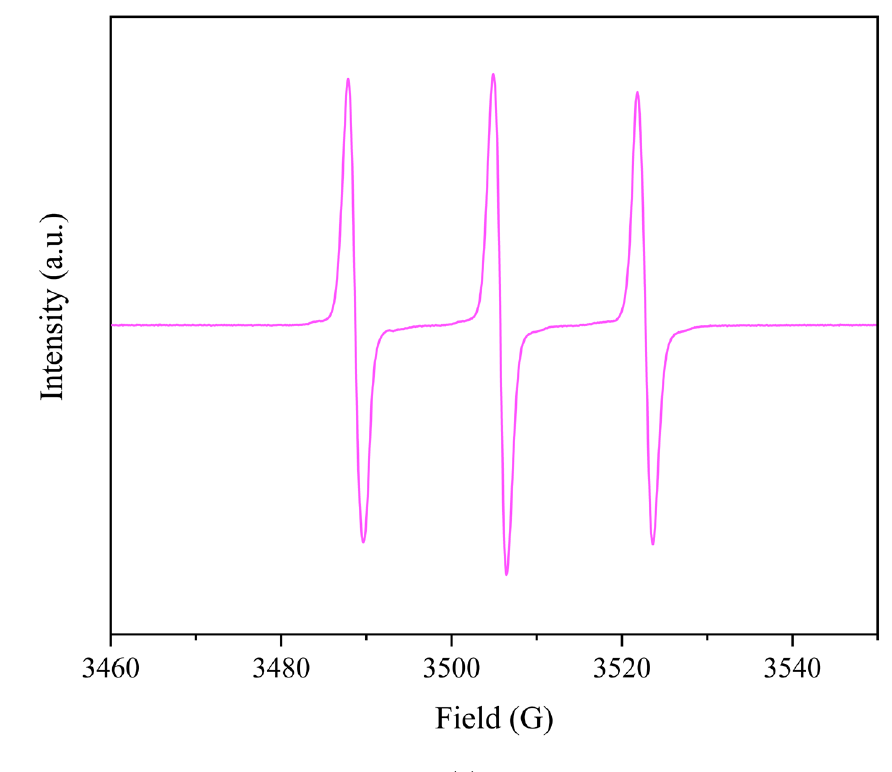
Figure 7. EPR spectra of SO 4• − and • OH ( a ), O 2• − ( b ) and 1 O 2 ( c ) in the CM/g-C 3 N 4 /PMS system. Reaction conditions: [PMS] = 1.0 mM, [CM/g-C 3 N 4 ] = 0.30 g/L, [RhB] = 10.0 mg/L, DMPO/TEMP = 0.10 M, 25 °C.